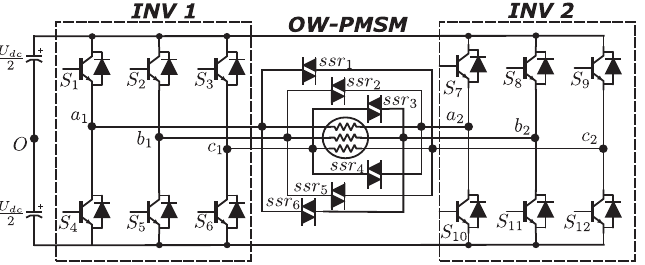
Figure 10. Fault-tolerant control of an open-end winding permanent magnet synchronous motor (OW-PMSM). The TRIACs allow reconnection of the winding with the faulty leg.